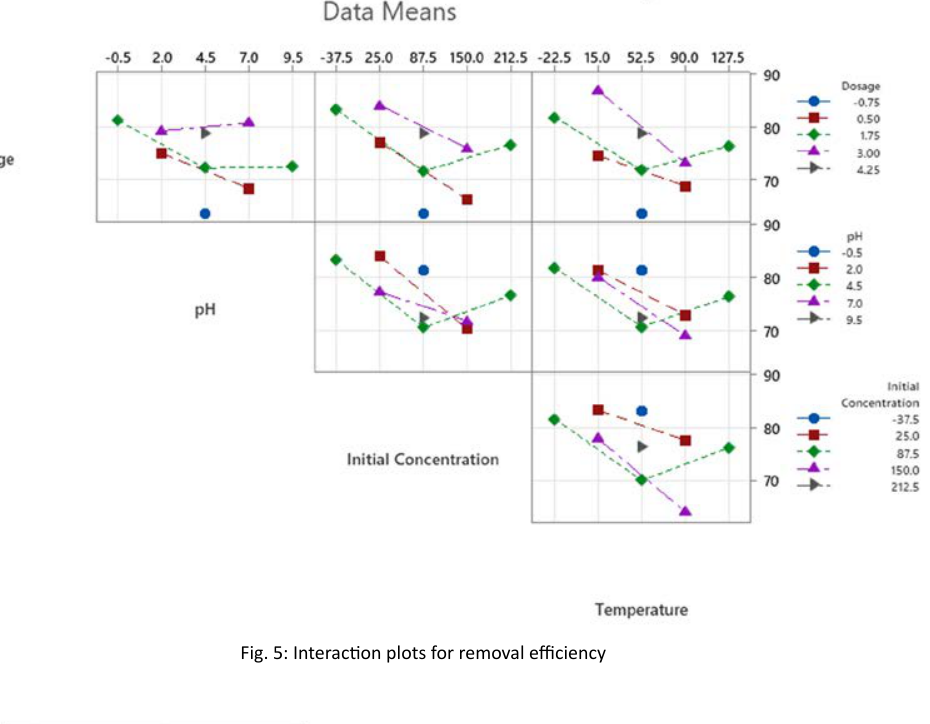
Fig. 5: Interaction plots for removal efficiency